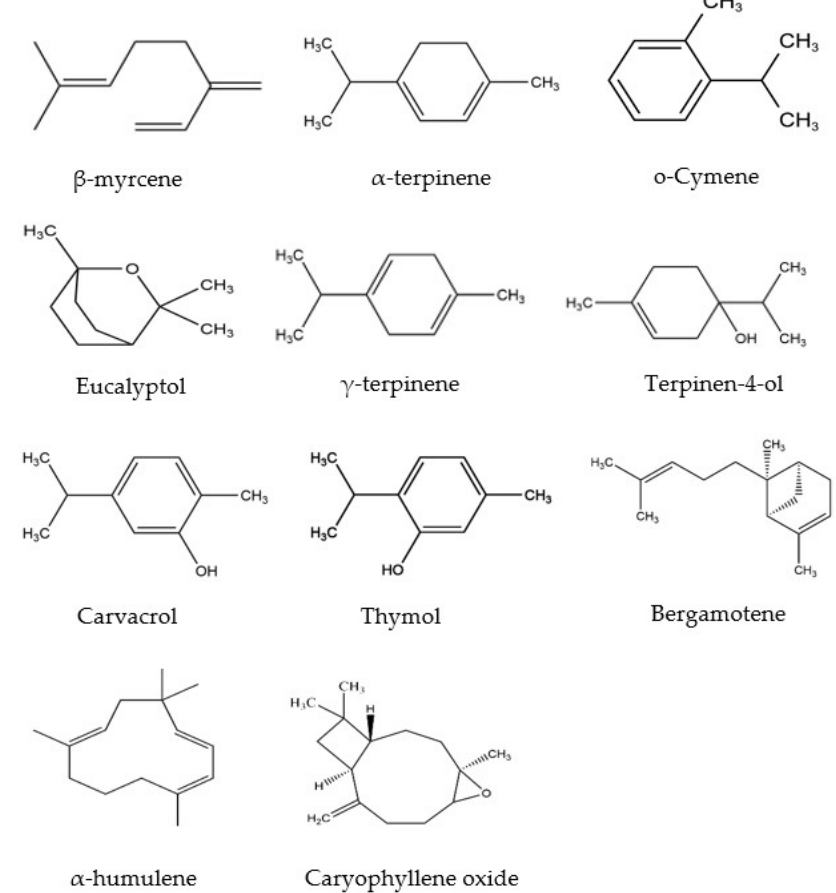
Figure 1. Chemical structures of the main components of M. Chinensis EO.